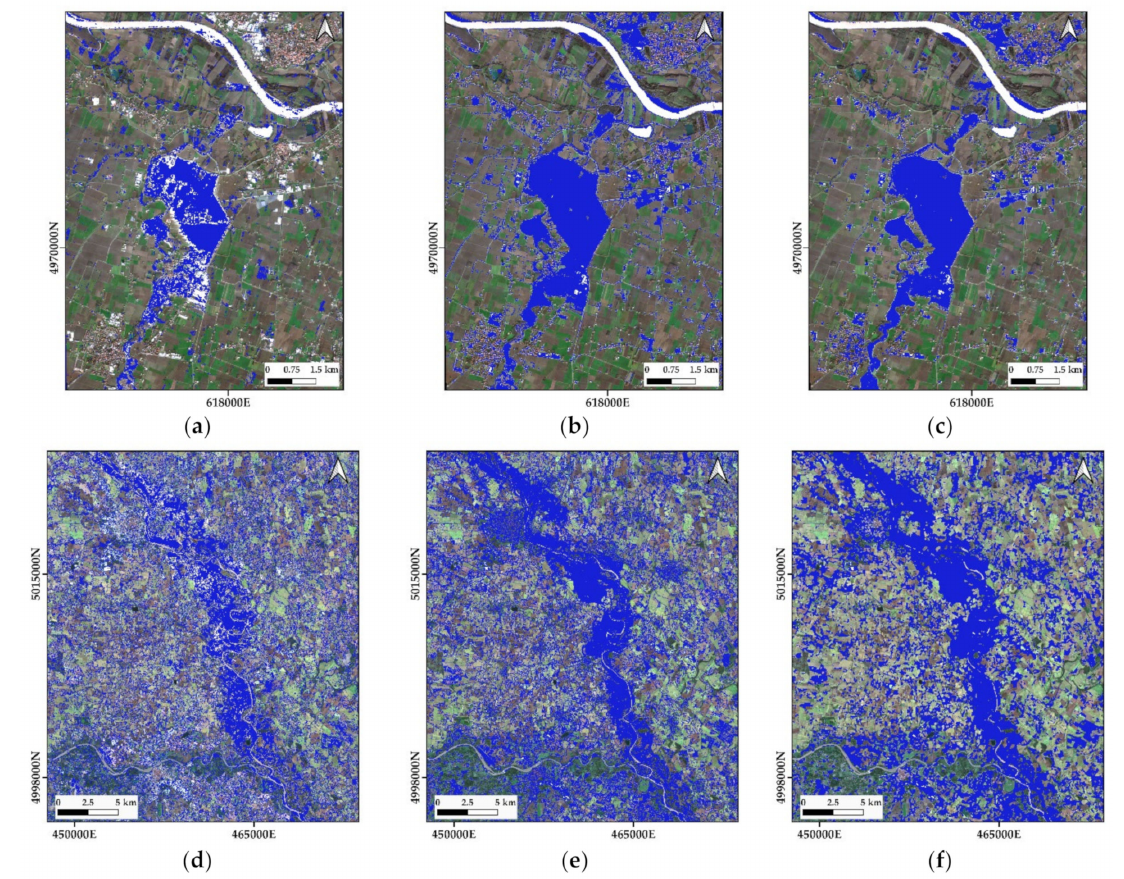
Figure 9. RF flood maps obtained for the two events in Enza (event 2017) and Sesia (event 2020) rivers by SAR ( a ) and ( d ), MS ( b ) and ( e ) and a combination of SAR and MS feature ( c ) and ( f ). Pixels classified as water are displayed in blue color, overlaid onto the RGB true color composite of flooding date. The backscatter data on 7 December 2017 and 27 September 2020 as well as the MS data on 24 October 2017 and 9 August 2020 were used to map the permanent water body areas by the Otsu thresholding